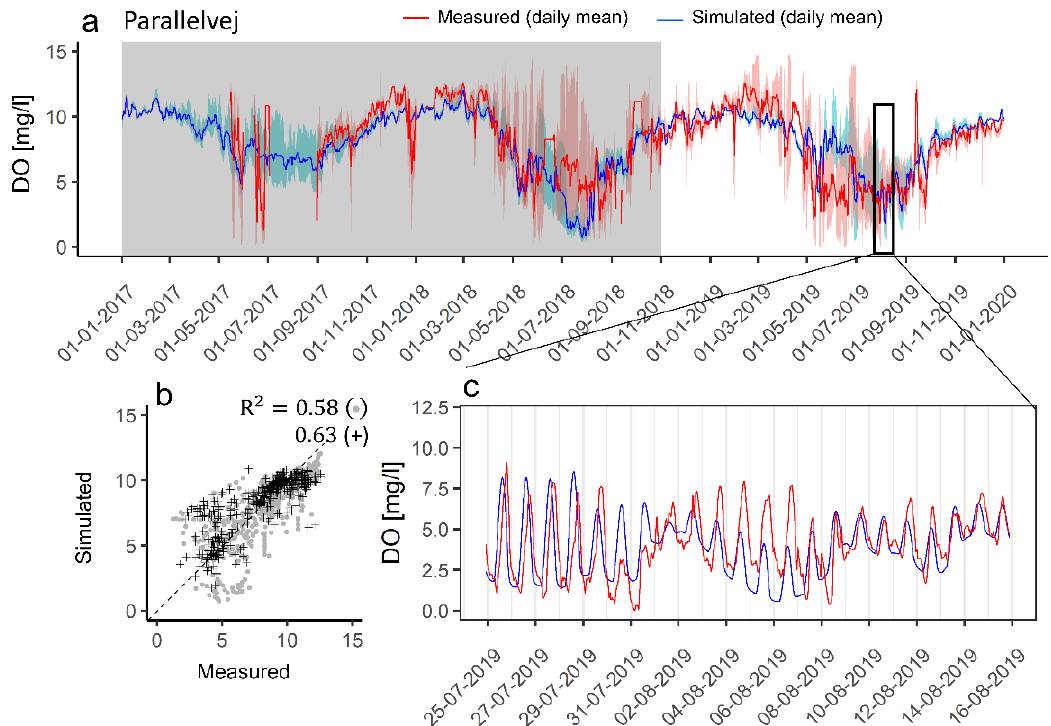
Figure 6. DO concentration simulation (blue line) compared to an online sensor measurement (red line) at Parallelvej, with ( a ) simulated and measured daily mean DO concentration for the calibration and verification period. The grey ribbon indicates the calibration period. The pale blue and red shadings correspond to the amplitude of simulated and measured daily extremes, respectively. ( b ) 1:1 scatter plot of simulated and measured daily average DO concentration (black cross- Water 2021 , 13 , x FOR PEER REVIEW 16 of 40 marker corresponds to the verification period, grey dot marker to the calibration period); and ( c ) simulated and measured hourly DO for a selected summer period showing the diurnal variation induced by plant photosynthesis/respiration.